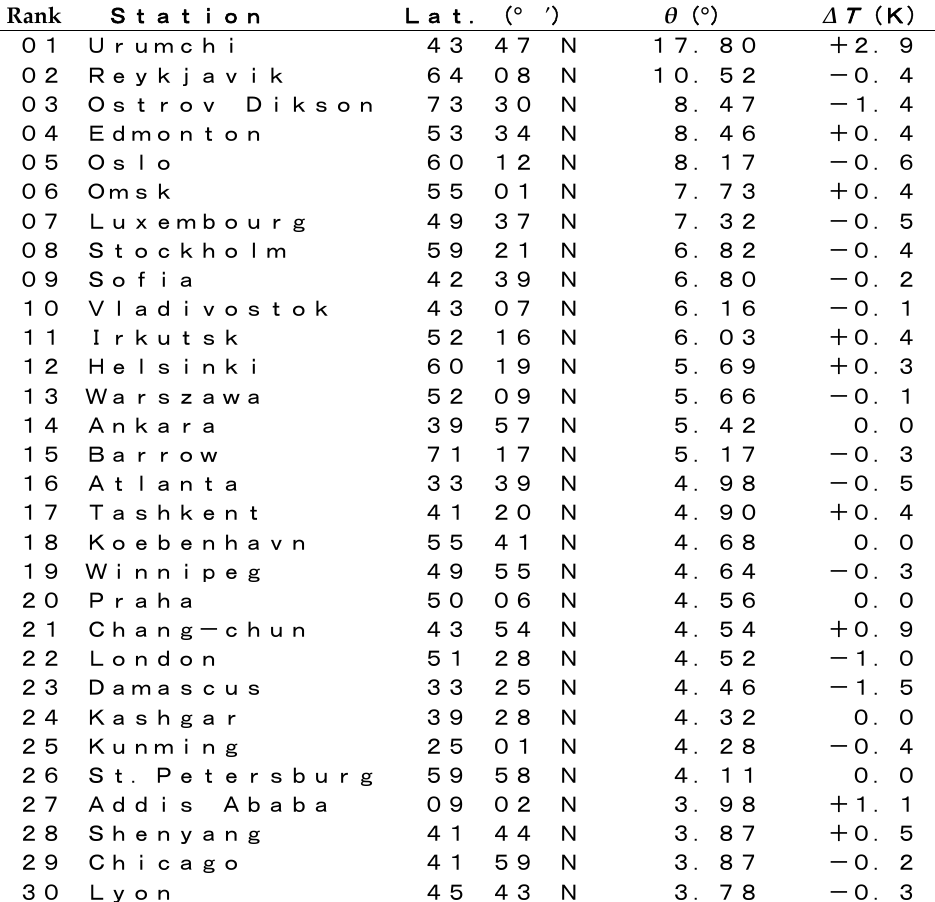
Table 1. Top ‐ thirty Northern Hemispheric stations in the rotation angle of the monthly distributions of temperatures from Period I (1931–1960) to II (1951–1980).